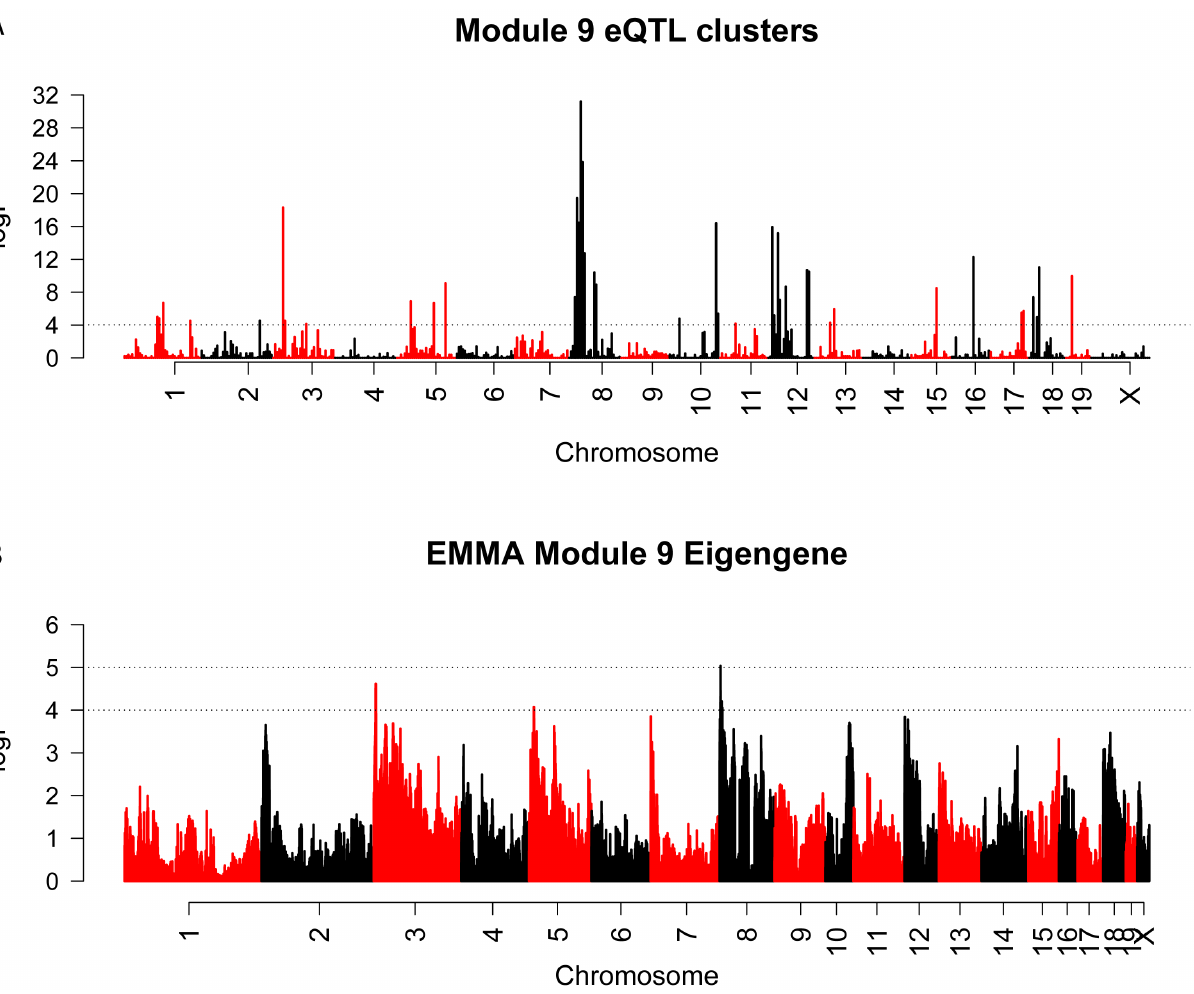
Figure 6. EQTL hotspot identification and genome-wide association identifies a regulator of M9 on Chromosome 8. (A) Genome-wide scan for regions associated with the expression of a large number of M9 genes. The dashed line is a genome-wide significance threshold of 2 log10(P=9.4 6 10 2 5 ). (B) EMMA genome-wide association scan for the M9 eigengene.